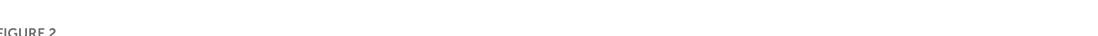
FIGURE2 HFD/LFD + TM: n = 5, HFD/LFD + TM + TRF: n = 5; total n = 30). Blue dots and box plots indicate HFD groups, and yellow dots and box plots indicate dietary change to LFD. Table displays the individual groups, respectively. Table is read from top to bottom; “+” denotes implementation of a given diet or intervention and “ − ” its absence. Significance of differences between groups was tested with either the Kruskal–Wallis test, followed by Dunn’s post hoc test for multiple comparisons (B) , the Brown–Forsythe test, and Welch’s ANOVA with the Tamhane T2 post hoc test for multiple comparisons [ C: F value ( F ) = 51.82, degree of freedom (DF) = 5; D: F = 66.19; DF = 5. F: F = 22.68, DF = 5], or by ordinary one-way ANOVA with Tukey’s post hoc test for multiple comparisons (E) . Data are presented as mean ± SD, and statistical significance was set at p < 0.05. HFD, high-fat diet; LFD, low-fat diet; TM, treadmill; TRF, time-restricted feeding.